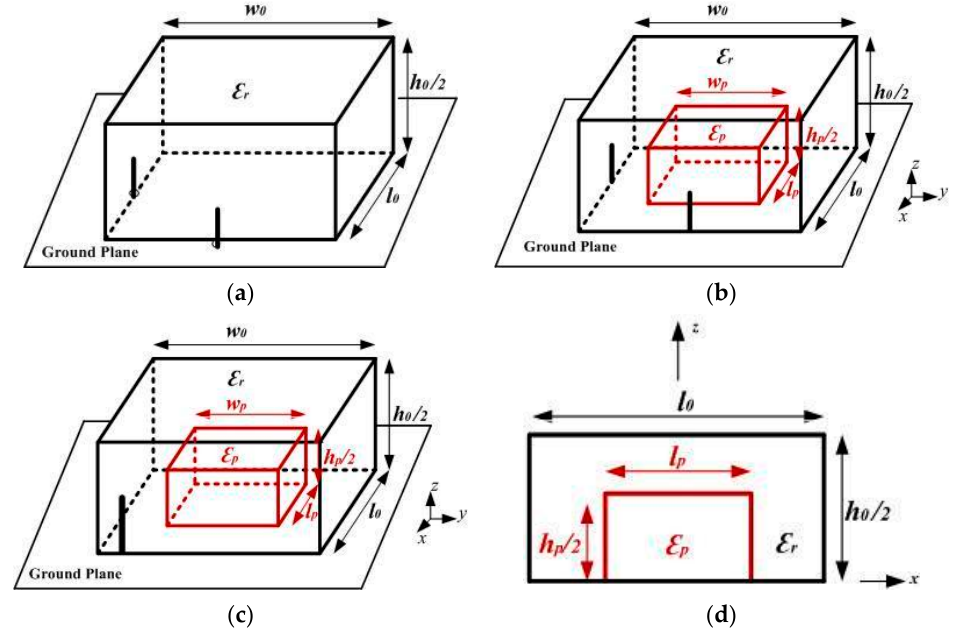
Figure 1. ( a ) Configuration of the original RDRA. ( b ) Configuration of the inhomogeneous RDRA. ( c ) Front view of the circularly polarized inhomogeneous RDRA. ( d ) Side view of the circularly polarized inhomogeneous RDRA.